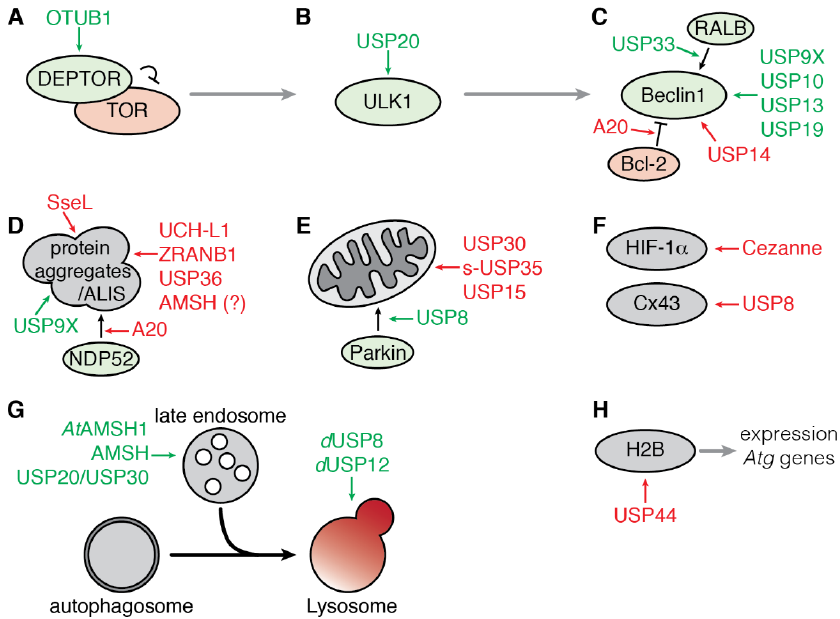
Figure 3. Functional roles of eukaryotic deubiquitinating enzymes in autophagy. ( A ) DEPTOR interacts with mTOR and inhibits its kinase activity. Under nutrient-rich conditions, DEPTOR is degraded continuously, and mTOR is active, promoting cell growth. However, under nutrient shortage, DEPTOR is stabilized by deubiquitination by OTUB1, interacts with mTOR and inhibits its kinase activity, allowing for the induction of autophagy. ( B ) The deubiquitination of ULK1 by USP20 allows for its stabilization and promotion of autophagy induction. ( C ) Beclin1 is an essential modulator of the PI3K-III complex. Beclin1 ubiquitination is crucial to its function. Deubiquitination by A20 inhibits Beclin1 activity by promoting its interaction with the inhibitor Bcl-2. USP14 negatively regulates Beclin1 activity. Other DUBs positively regulate autophagy by stabilizing Beclin1 (USP9X, USP10, USP13, USP19). The deubiquitination of RALB by USP33 benefits their interaction and the induction of autophagy. Ubiquitination also mediates the degradation of selected cargoes by autophagy. ( D ) The deubiquitination of α -synuclein aggregates by USP9X favor their degradation by autophagy, while UCH-L1 contribute to the accumulation of α -synuclein by downregulating its lysosomal degradation. The deubiquitination of various protein aggregates by ZRANB1 or USP36 impairs their degradation by autophagy. Invasion by intra-cellular bacteria tends to induce the accumulation of aggregate-like structures (ALIS) which are ubiquitinated and contribute to the induction of bacterial clearance by xenophagy; the DUB-like enzyme Ssel secreted by Salmonella deubiquitinates ALIS, resulting in a downregulation of autophagy and better survival of the bacteria. ( E ) Mitophagy selectively degrades mitochondria. USP8 promotes Parkin-mediated mitophagy by deubiquitinating Parkin and promoting its recruitment to the mitochondria. USP30, s-USP35, and USP15 counteract Parkin by deubiquitinating Parkin’s substrates, thus impairing mitophagy. ( F ) Specific ubiquitinated substrates can also be targeted for autophagy. Deubiquitination of HIF-1 α and Connexin-43 (Cx43) by Cezanne and USP8, respectively, prevents their lysosomal degradation. ( G ) Autophagosomes can fuse with the endosomes. This fusion requires the ESCRT machinery as well as AMSH (AtAMSH1 in A. thaliana ). USP20 and USP30 to a lesser extent favor the direction of the β 2-adrenergic receptors to the autophagosome for degradation. In Drosophila , dUSP8 and dUSP12 positively regulate autophagy by contributing to the biogenesis of the lysosome. ( H ) Deubiquitination of H2B by USP44 negatively regulates the transcriptional activation of autophagy. Legend: Colored arrows show the action of DUBs that support (green) or inhibit (red) autophagy. Pink proteins are molecular inhibitors of autophagy; green proteins are inducers of